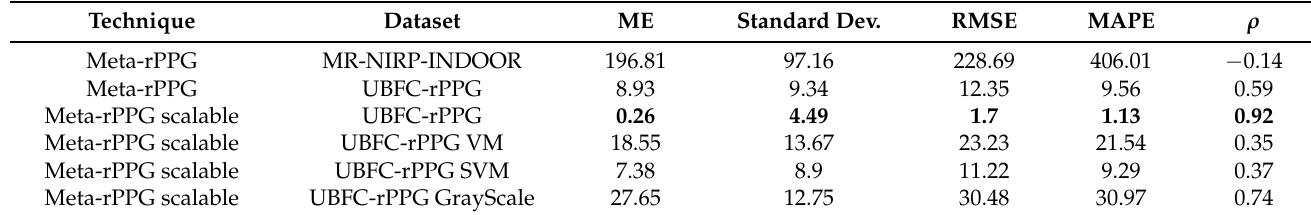
Table 4. Comparison of Meta-rPPG network